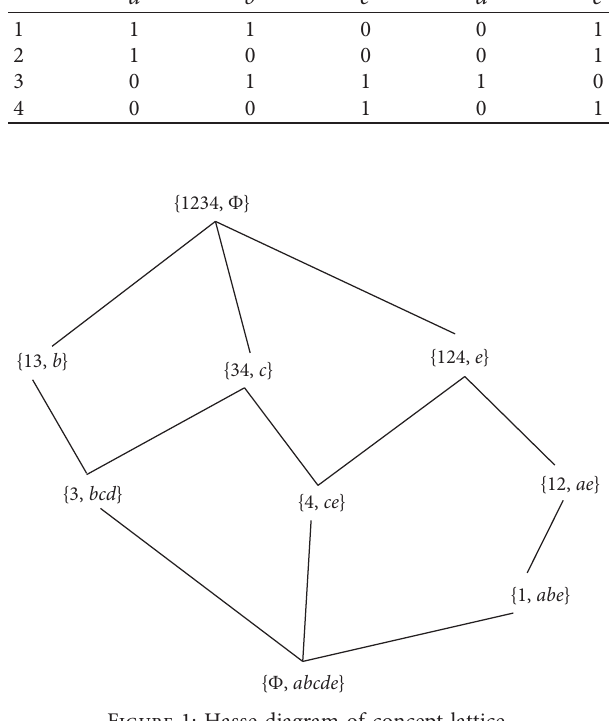
Figure 1: Hasse diagram of concept lattice.